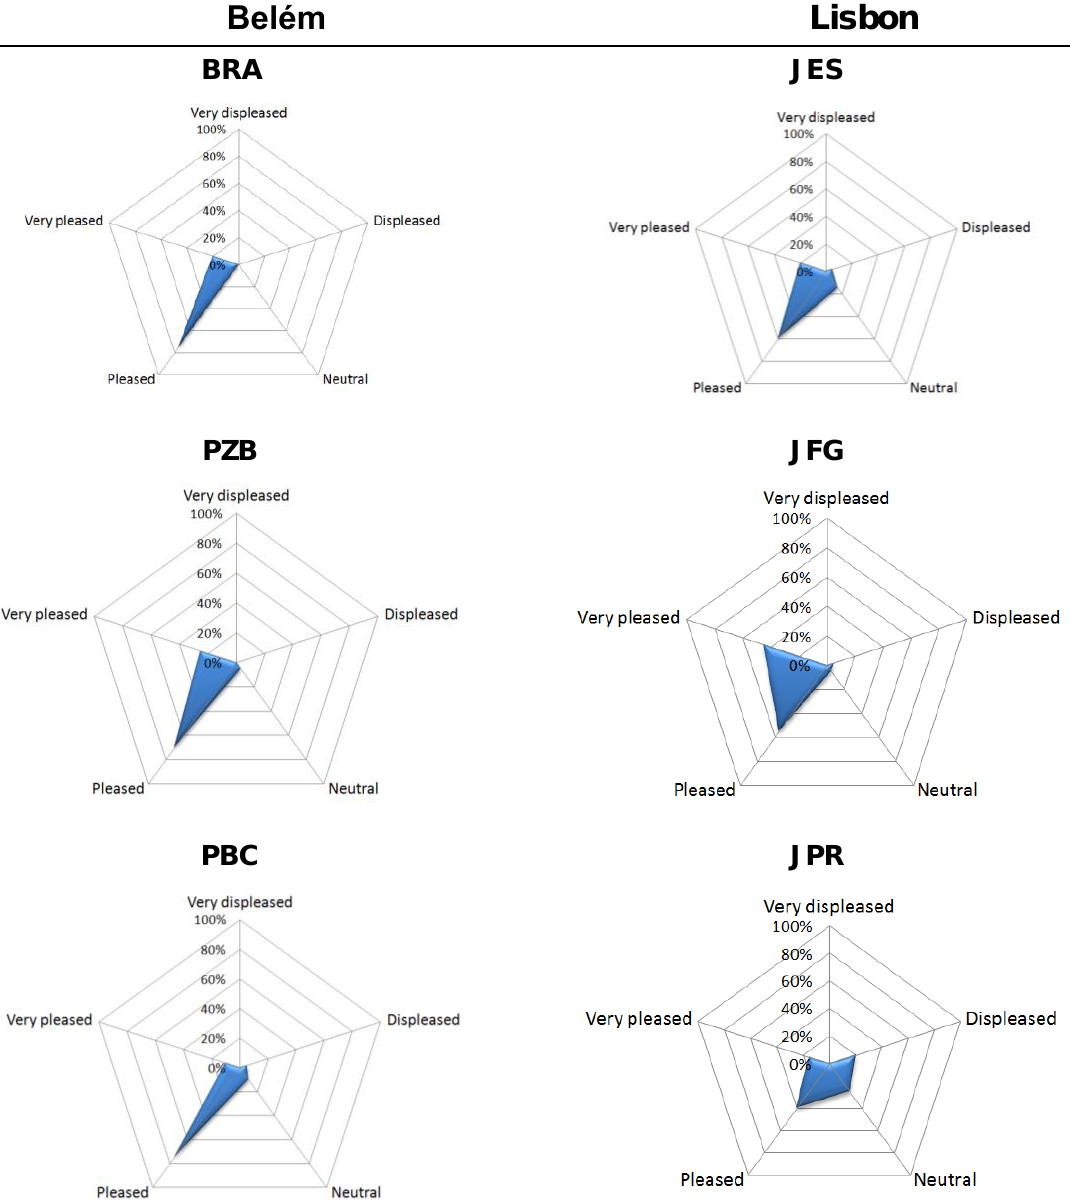
Figure 9: Evaluation of peacefulness in Brazilian (left column) and Portuguese (right column) parks by their visitors.